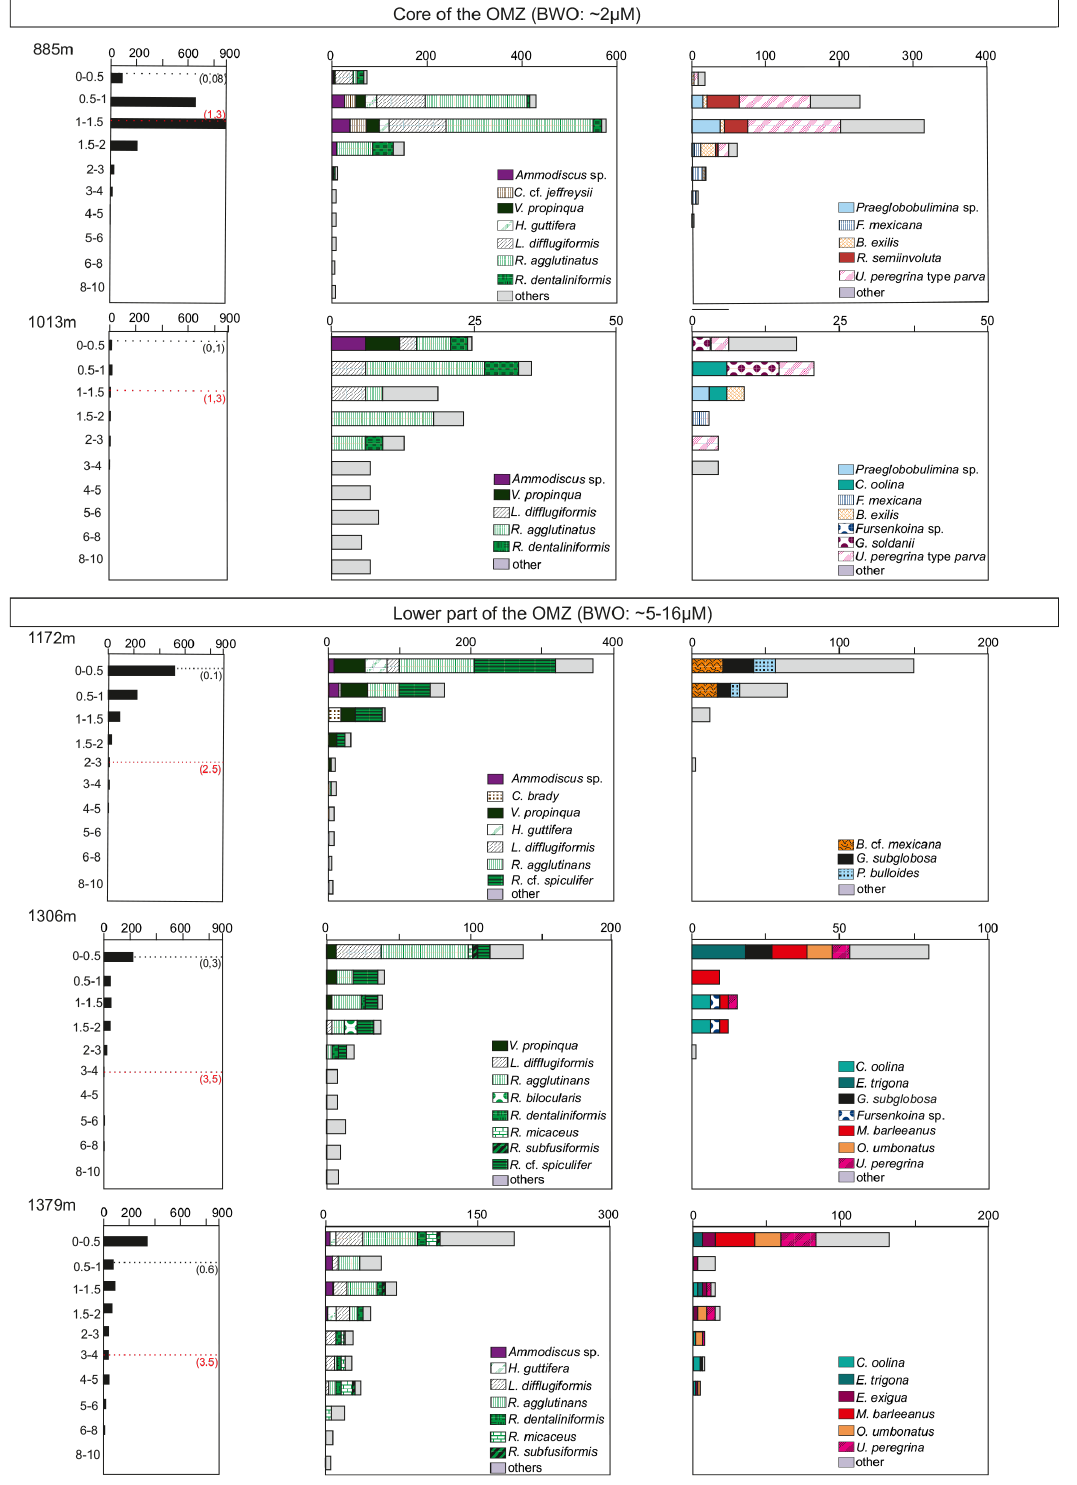
Fig. 4. Vertical densities (ind/50cm 3 ) and abundances (ind/50cm 3 ) of the dominant live foraminiferal species ( > 5% for each station) in the > 125µm fraction. The first panel of each row represents the total foraminiferal densities. The black dotted line refers to the oxygen penetration (cm) into the sediment, and the red dotted line to the nitrate penetration depth (cm). The second panel of each row represents the vertical distribution of the dominant agglutinated taxa. The third panel of each row represents the vertical distribution of the dominant hyaline and miliolid taxa. Note the different horizontal scales between the third and second panels and between